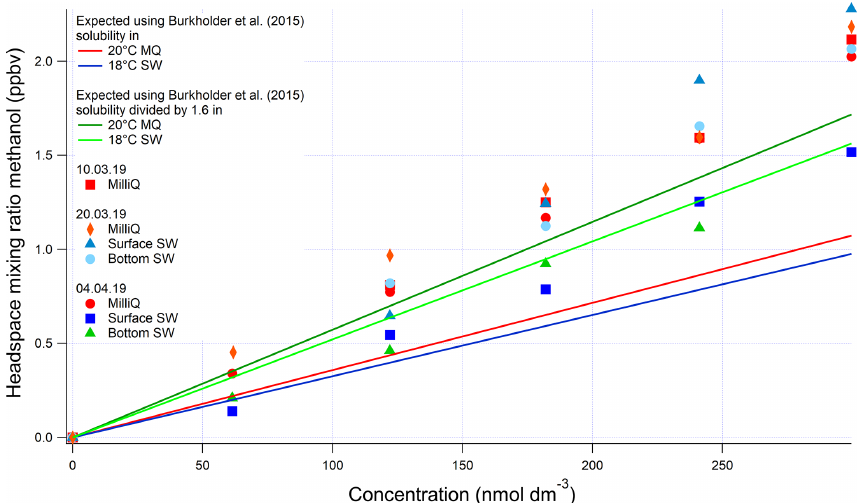
Figure A3. Evasion calibrations using liquid standards of methanol produced by serial dilution in different types of water (SW: seawater; MQ: Milli-Q water). Bottom SW refers to seawater collected from well below the mixed layer. Surface SW refers to seawater collected from the underway seawater inlet. The average measured slope in the four seawater calibrations is 0 . 00624 ± 0 . 00121ppbv(nmoldm − 3 ) − 1 (19%rel.SD), and the average slope in the four Milli-Q calibrations is 0 . 00678 ± 0 . 000254ppbv(nmoldm − 3 ) − 1 (3%rel.SD). Expected mixing ratios are slightly different between MQ and SW due to the lower seawater temperature.